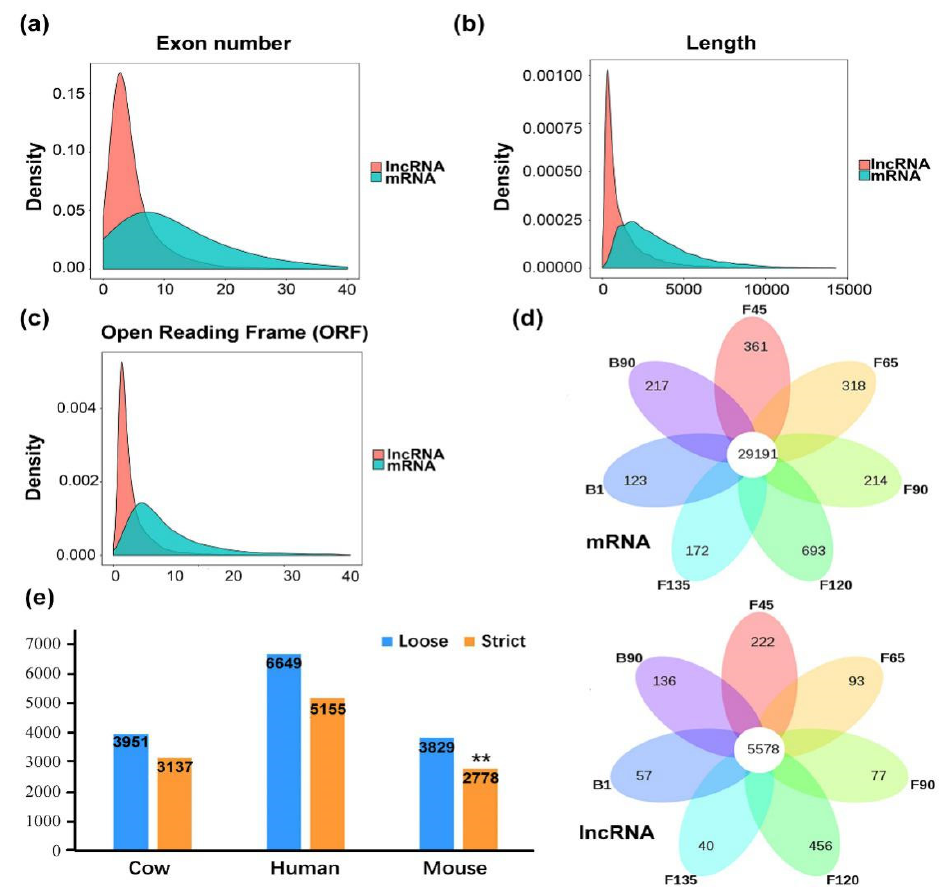
Figure 2. Goat skeletal muscle structure and conservation. ( a – c ) Exon number, transcript length and open reading frame (ORF) length distribution of transcripts for all lncRNAs and mRNAs in goat skeletal muscle. Red: lncRNA; Blue: mRNA. ( d ) Venn diagram of detected mRNAs (top) and lncRNA (bottom) at seven stages. ( e ) The number of NONCODE lncRNAs in cow, human, and mouse that are either a loose (E-value < 1 × 10 − 3 ) or strict (E-value < 1 × 10 − 10 ) threshold by BLASTN. (**) p -value < 0.05 by Fisher’s exact test with cow used as the background.